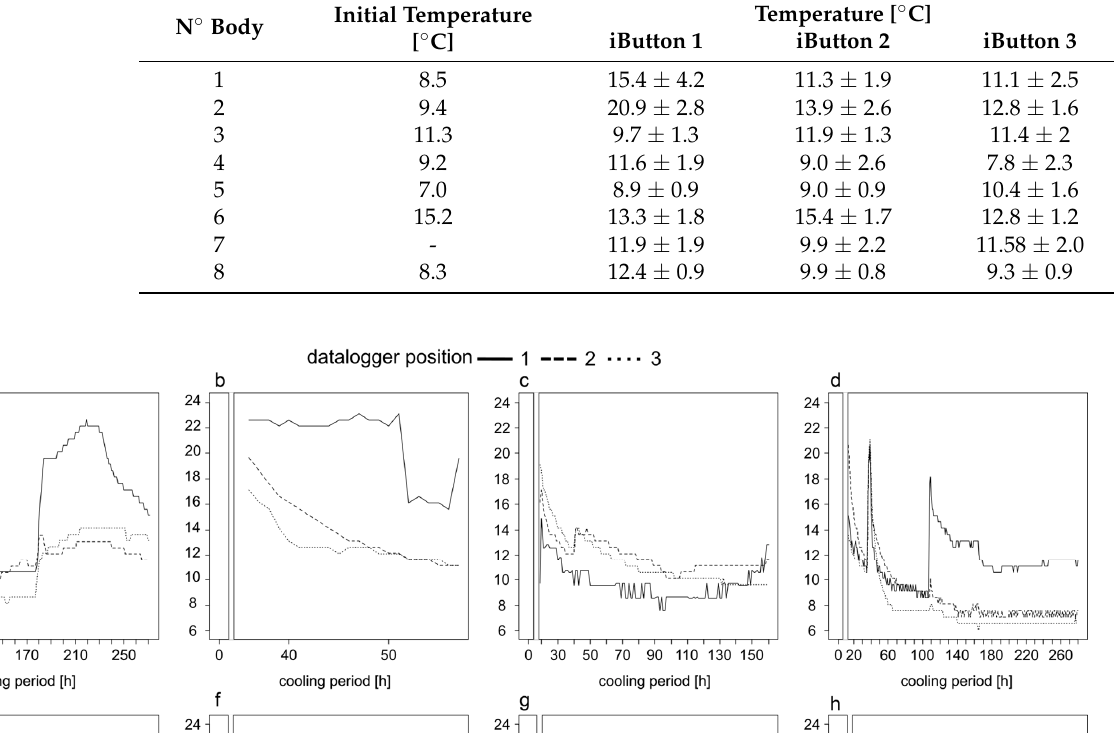
Table 2. Temperature difference between the three positions used for temperature measurement on each body. Information on the exact position and measurement periods are given in Table 1. “Temperature” shows the mean values over the measurement period with standard deviation; “Initial temperature” is the temperature in the cooler directly before the start of the measurements in the body bags. Its variation is explained by the routine activity and different opening and closing times of the walk-in cooler in the context of the delivery and examination of other bodies.